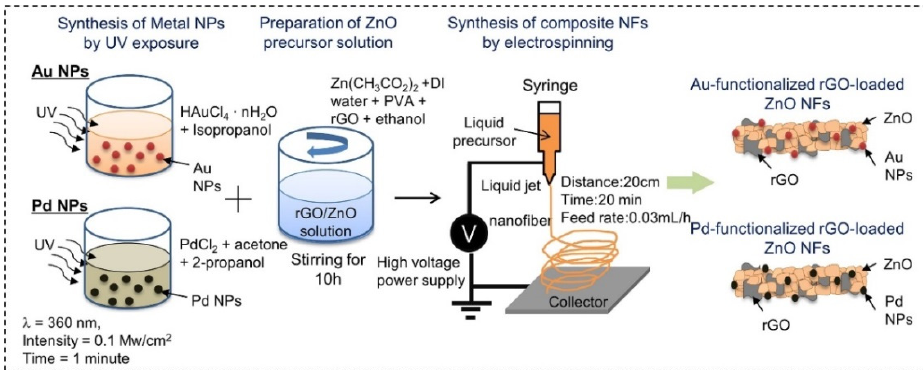
Figure 7. Preparation of Au and Pd-decorated rGO-loaded ZnO NFs [60].